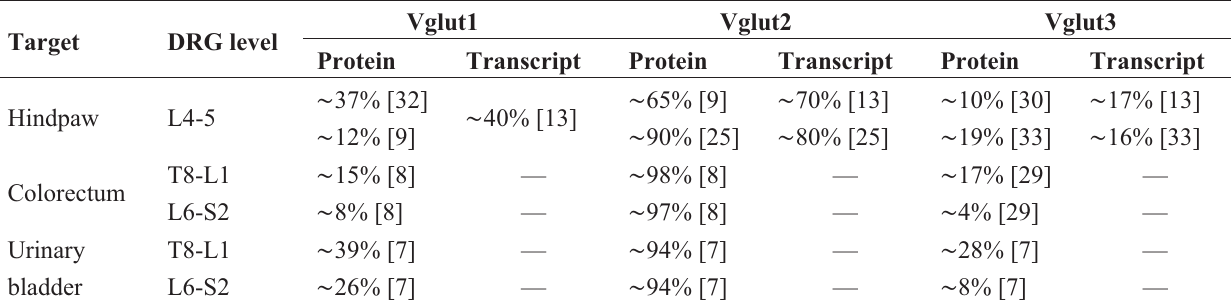
Table 1. Percentages of visceral and non-visceral DRG neurons expressing transcript and protein of VGLUT1-VGLUT3. Dashes shown data that has not been